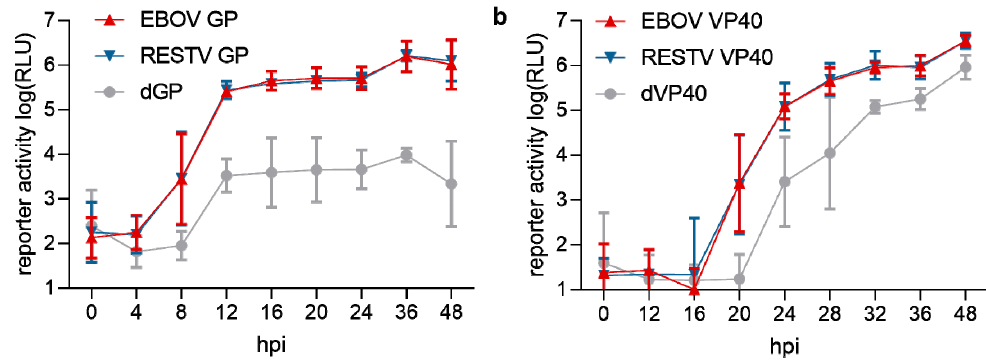
Figure 2. Comparison of EBOV and RESTV entry and budding e ffi ciencies. ( a ) Kinetics of entry for trVLPs carrying either EBOV GP (red), RESTV GP (blue), or no GP (dGP, grey) on their surface. trVLPs were produced in 293T cells by transfection of all necessary plasmids, including a tetracistronic minigenome encoding the di ff erent GP variants, harvested, and used to infect 293T target cells pre-transfected with expression plasmids for EBOV RNP proteins. The target cells were lysed at the depicted time points post-infection, and the luciferase activity was measured. ( b ) Budding e ffi ciencies of trVLPs produced by EBOV VP40 (red), RESTV VP40 (blue), or no VP40 (dVP40, grey). trVLPs were produced, as described above, but using tetracistronic minigenomes encoding either EBOV VP40, RESTV VP40, or no VP40. trVLPs were harvested at the depicted time points post-transfection and used to infect 293T target cells pre-transfected with expression plasmids for EBOV RNP proteins. Means and standard deviations of 3 ( a ) or 6 ( b ) independent experiments are shown. trVLPs, transcription and replication-competent virus-like particles; GP, glycoprotein; RNP, ribonucleoprotein.